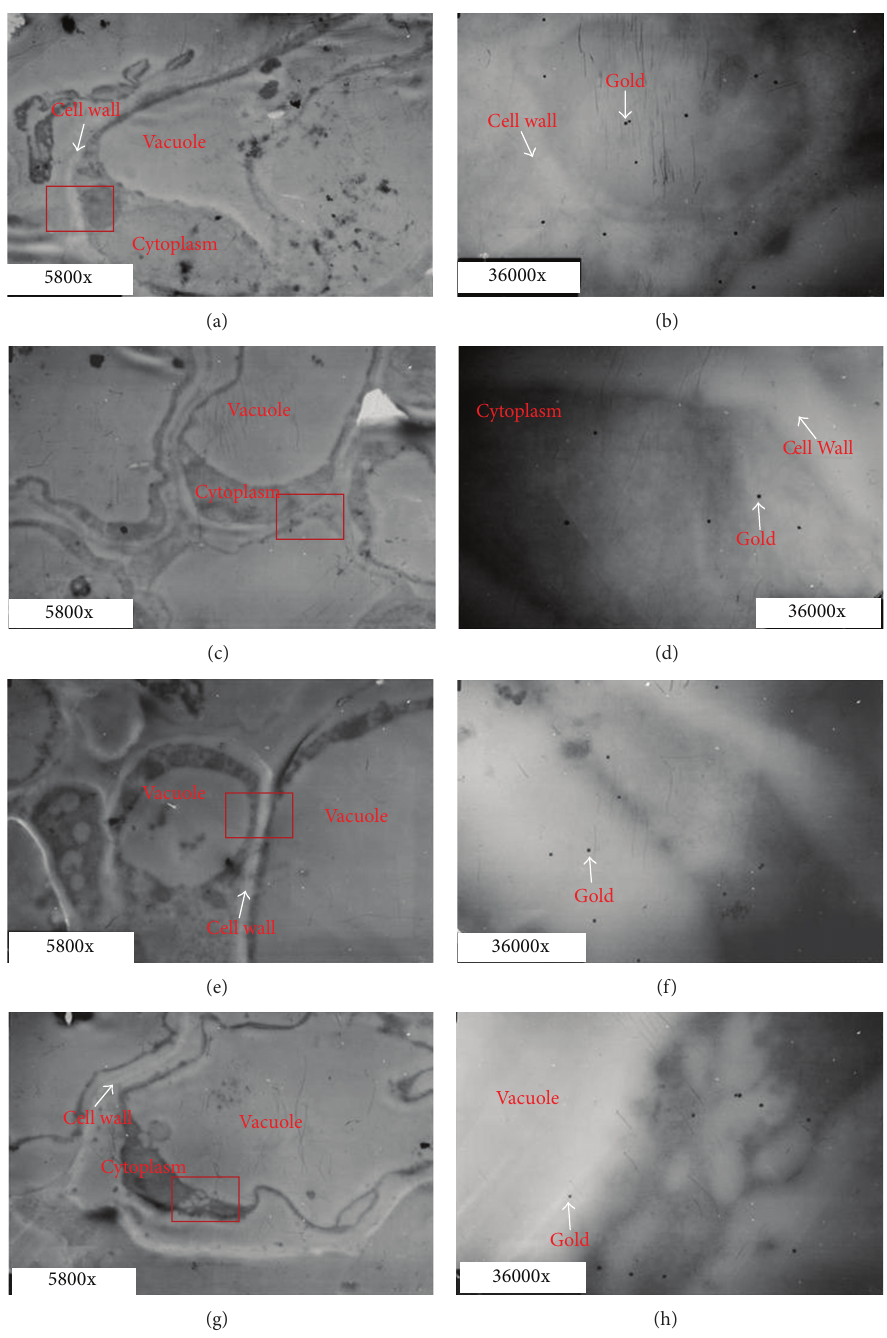
Figure 6: Transmission electron micrographs of tomato pedicel and localization of polygalacturonase (PG) in abscission zone cells by immunogold labeling (16h). (a) and (b): cortex; (c) and (d): vascular region; (e) and (f): central parenchymatous region; (g) and (h): vacuole; (b), (d), (f),and (h) are enlarged photos for the rectangles region in (a), (c), (e), and (g), respectively.